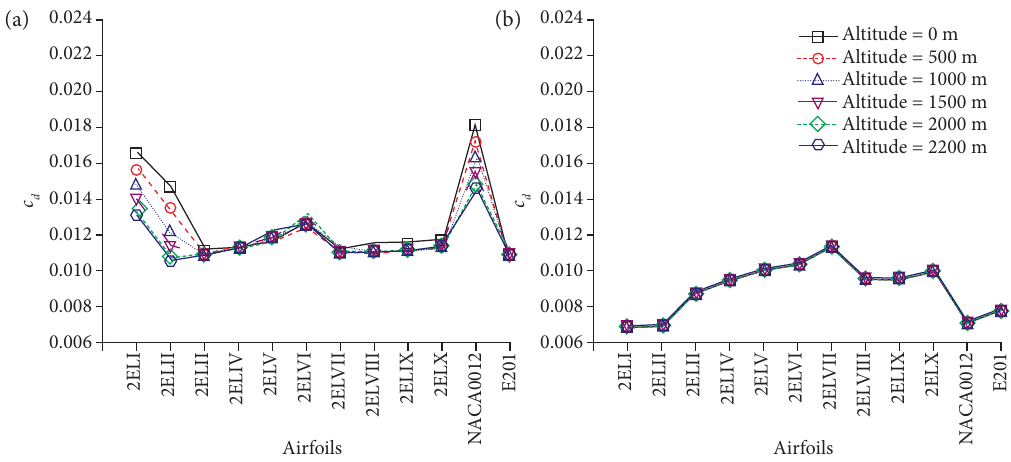
Figure 11. Drag coefficients for required lift coefficients (three-element). (a) Re = 2.5 × 10 5 ; (b) Re = 4.8 × 10 5 .